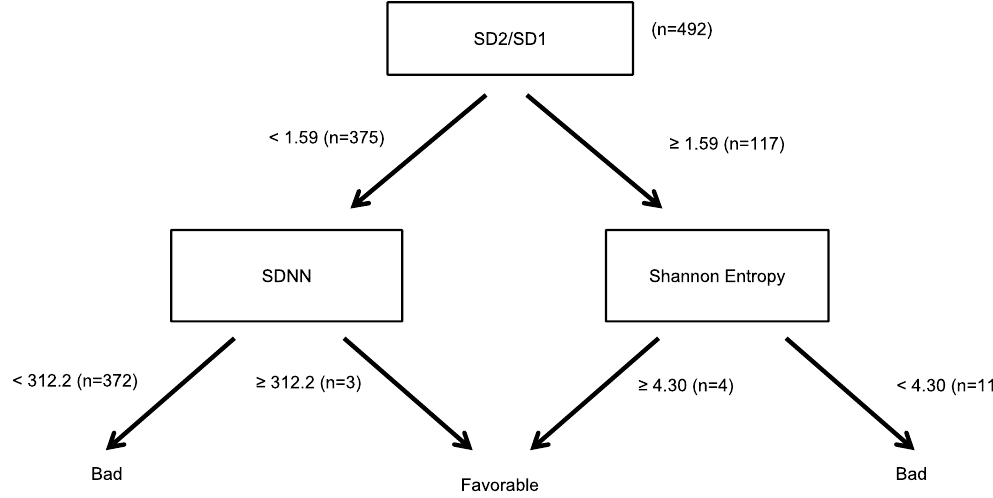
Figure 1. Decision tree for outcome evaluation following admission in the ICU. NN normal interbeat, SD1 standard deviation 1, SD2 standard deviation 2, SD2/SD1 ratio SD2/SD1, SDNN standard deviation of NN, Bad a bad outcome was defined as either death and/or any form of respiratory assistance and/or a median ICU stay higher than the median, Favorable a favorable outcome was defined as the occurrence of none of the previous adverse